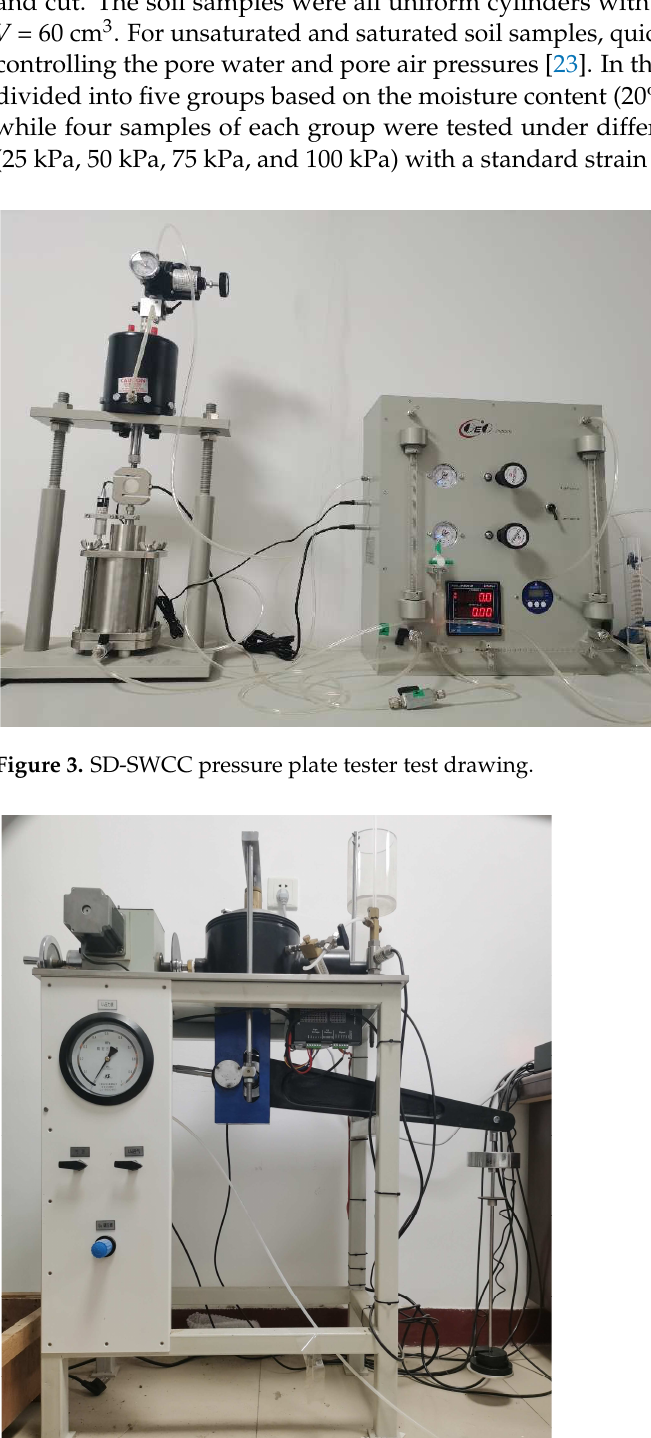
Figure 5. Sample dehumidification curve.